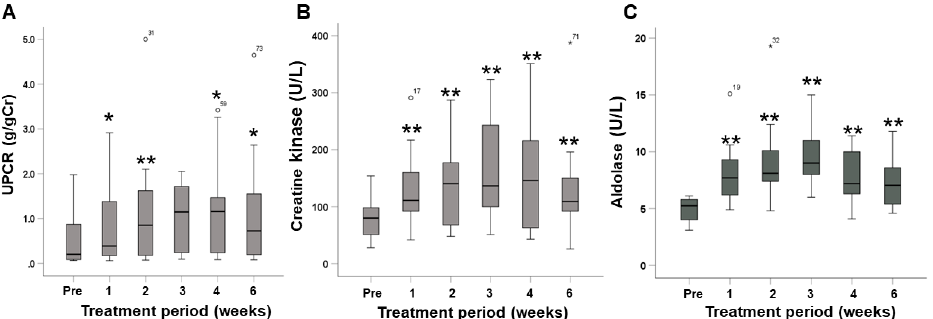
Figure 2. Time courses of the urine protein-to-creatinine ratio (UPCR) ( A ), serum creatine kinase ( B ), and serum aldolase ( C ) during cabozantinib treatment using box-and-whisker plots. The boxes span data between two quartiles (IQR, interquartile range), while the central line in each box represents the median of each group. The vertical lines represent the smallest and largest values that are not outliers. Outliers are values between 1.5 and 3 IQRs from the end of the box. * p < 0.05 vs. pre. ** p < 0.01 vs. pre.